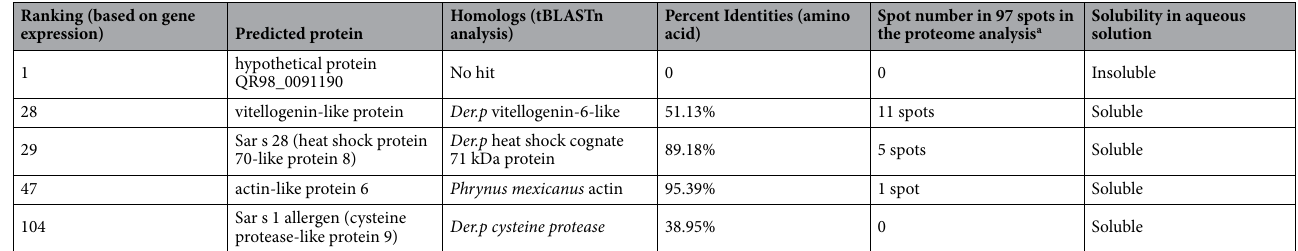
Table 4. Abundances of annotated genes in the S. scabies transcriptome. a From Morgan et al. 18